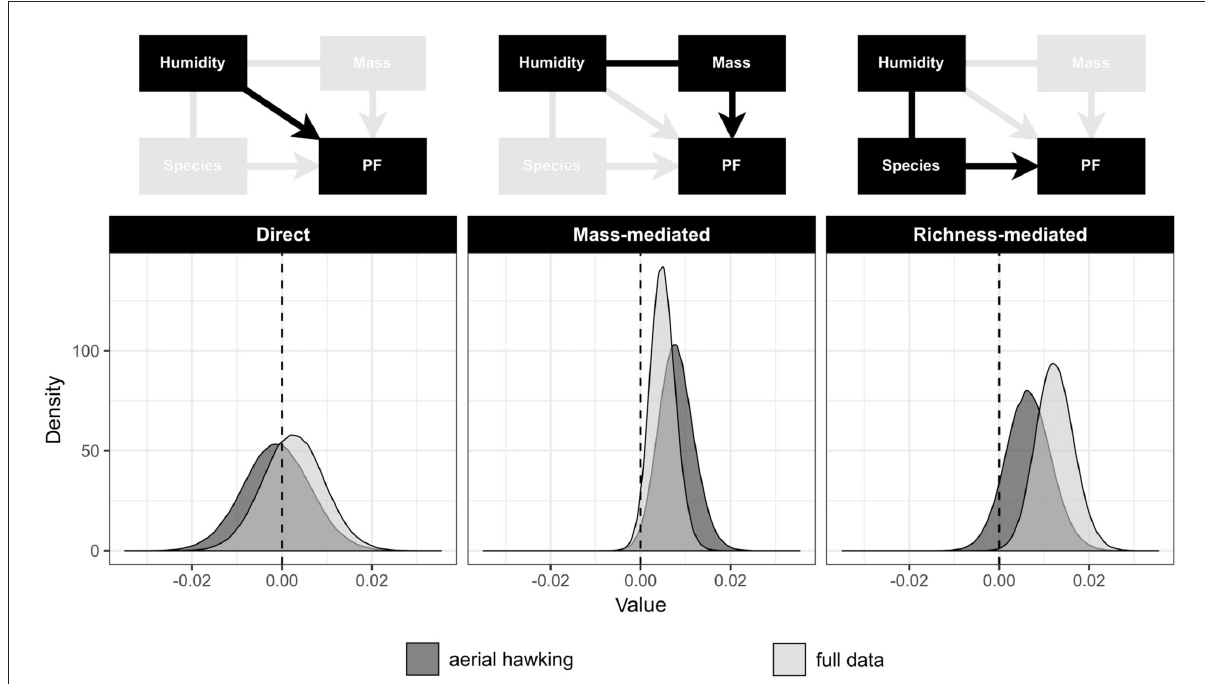
FIGURE4 Posterior distributions for the direct and indirect effects of humidity on peak frequency from the path analysis for the aerial hawking subset and full data: Plotted distributions consist of 200,000 posterior samples each because thinning factor of 10 was applied prior to plotting.